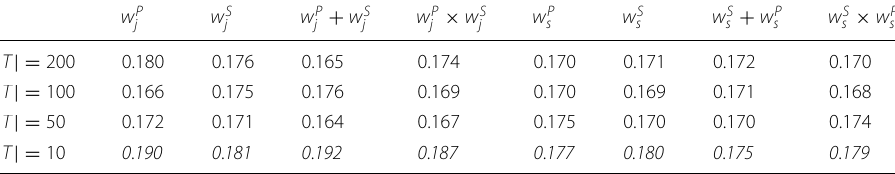
Table 5 Coherence scores of different weighting methods for the weighting model